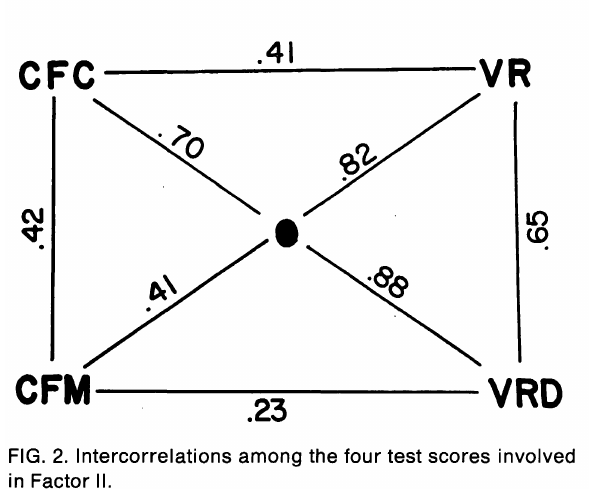
FIG. 2. Intercorrelations among the four test scores involved in Factor